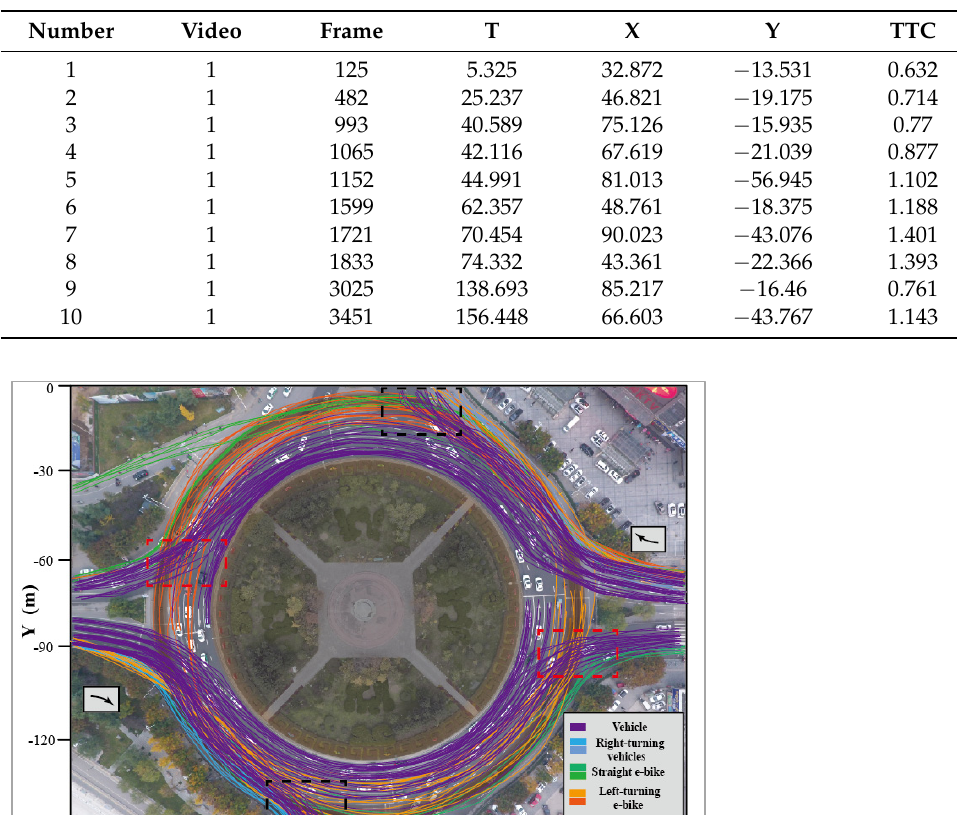
Table 3. Conflict data information.